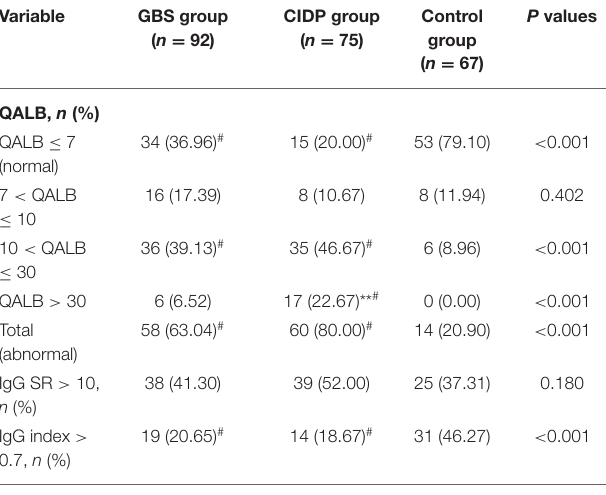
TABLE 2 | Comparison of blood and cerebrospinal fluid indexes in the GBS, CIDP and control groups M (P25–P75) . Variable